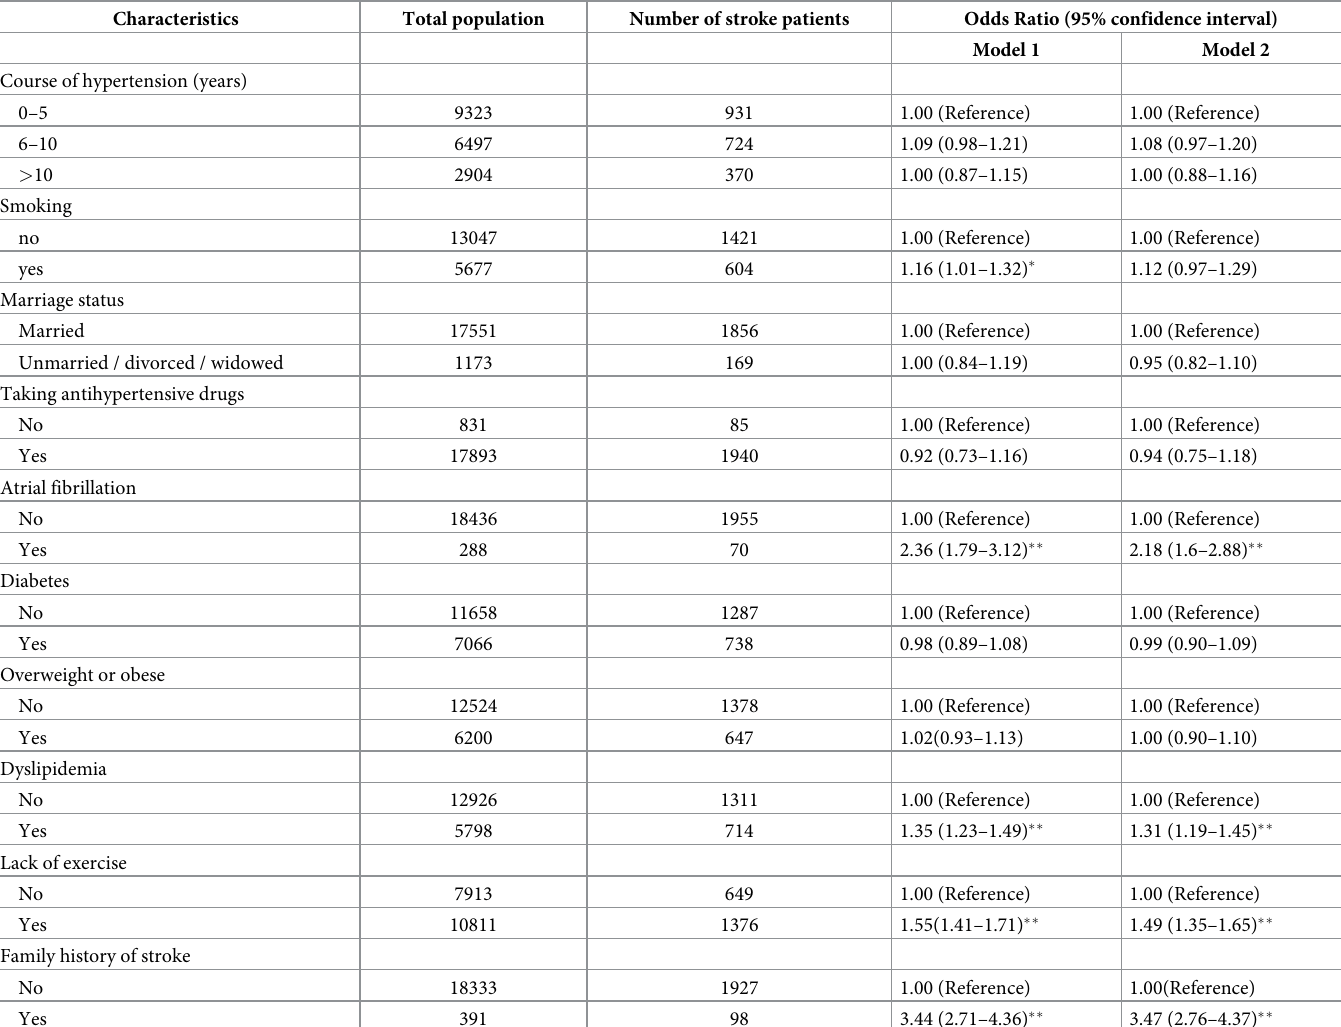
Table 2. Multivariable logistic regression analysis for influencing factors of stroke.